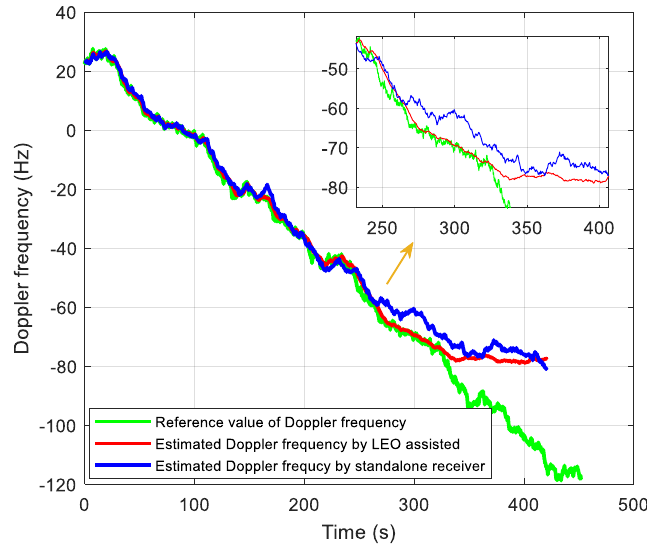
Figure 15. Performance comparison of frequency tracking.